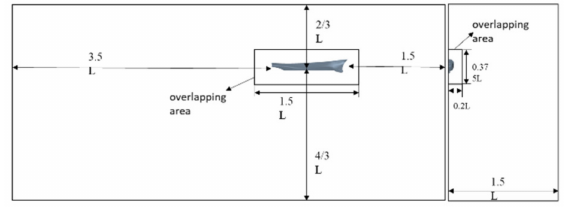
Figure 1. The division of computing area.